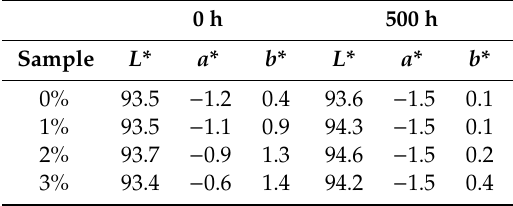
Figure 13. Color di ff erences ( ∆ E ) as manufactured (blue columns related to 0%) and after 500 h exposure at xenon lamp (green-related to its value at 0 h) of all organic coatings. Table 4. Color parameters ( L *, a *, b *) of each PA11 coating at 0 h and 500 h of xenon